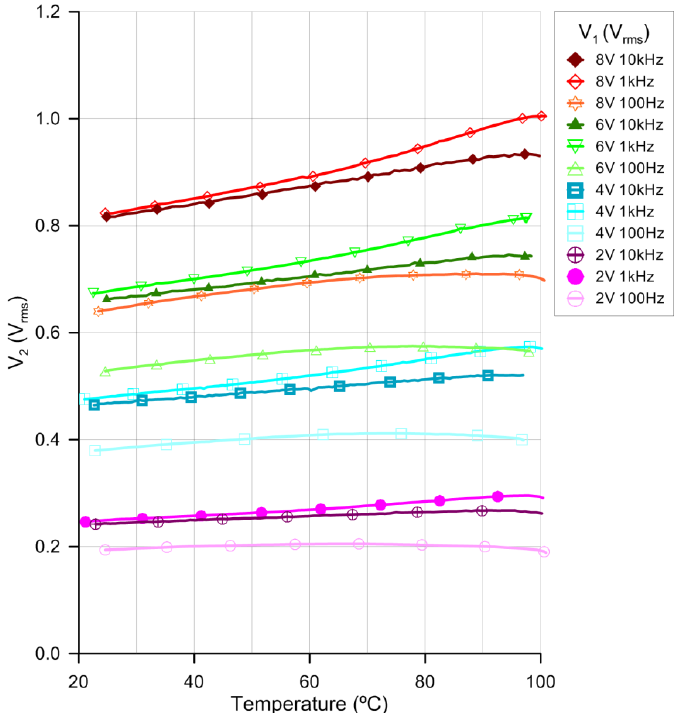
Figure 6. Temperature dependence of the LC sensor response for several voltages and frequencies at V 1